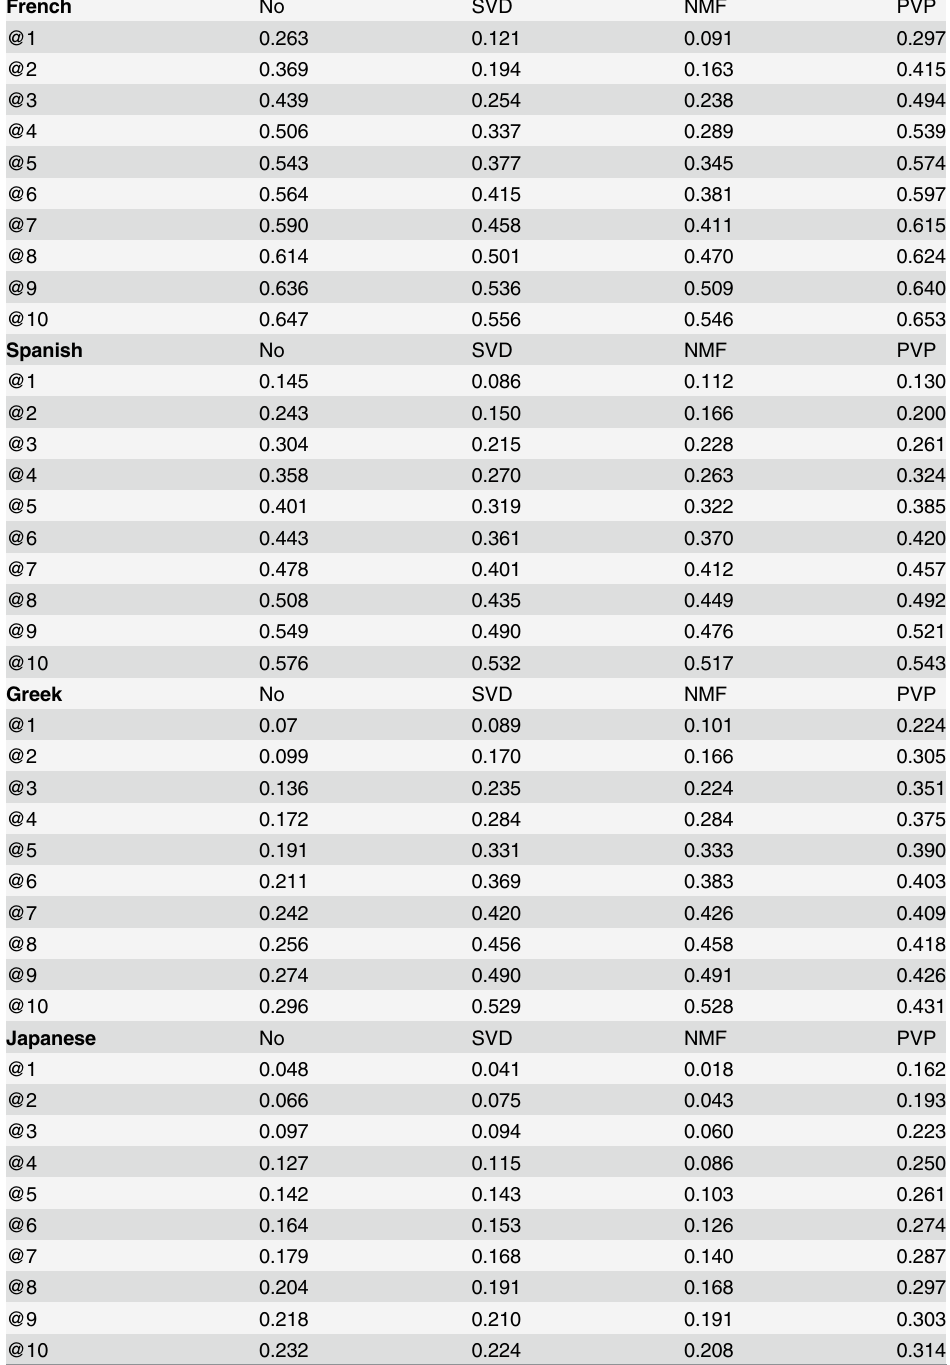
Table 3. Precision@rank values for English as the source language and different target languages using character n-gram